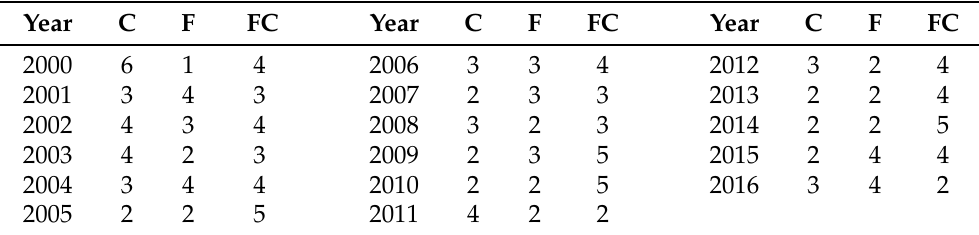
Table A3. NBA All-Star data: Number of players selected for the NBA all-star game each year in each position (C = Center; F = Forward; FC =